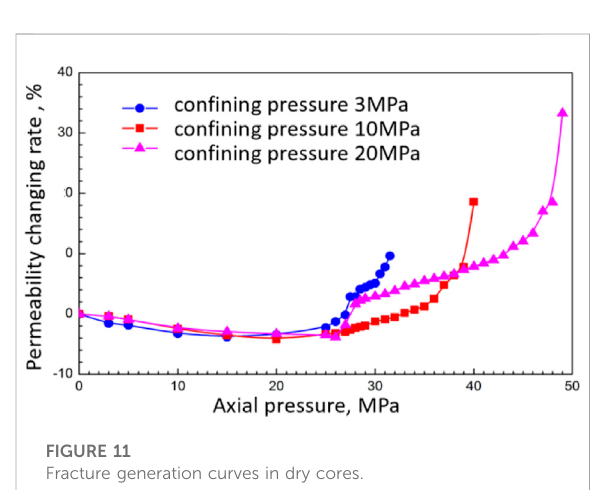
FIGURE 11 Fracture generation curves in dry cores.